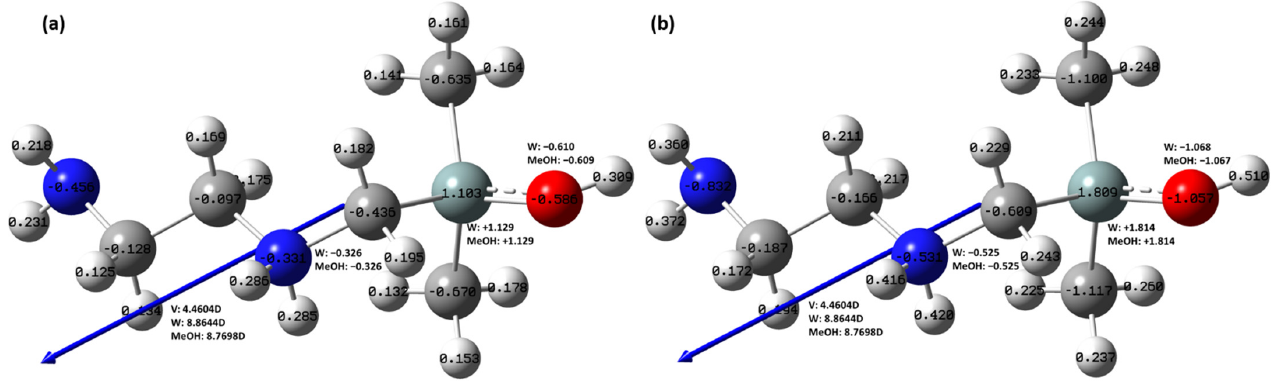
Figure 8. Partial charges for H-silanol: ( a ) Mulliken, ( b ) NPA from NBO; implicit solvents: W— water, MeOH—methanol, V—vacuum.